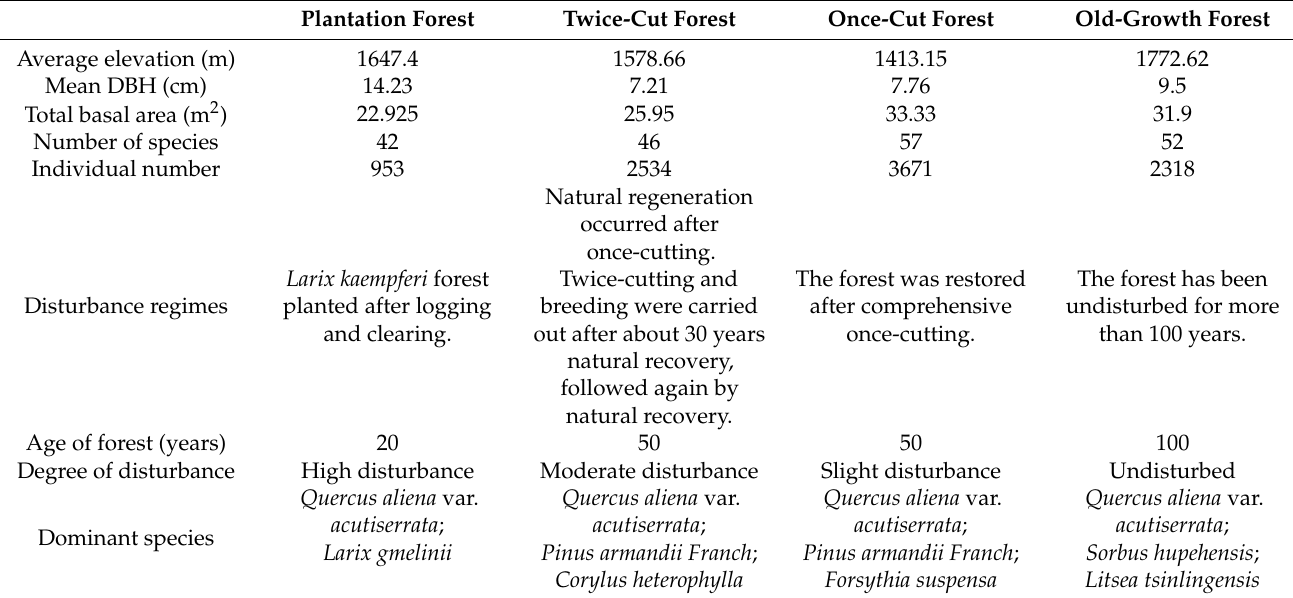
Table 1. Summaries of disturbance regime forest plots in Baiyunshan Nature